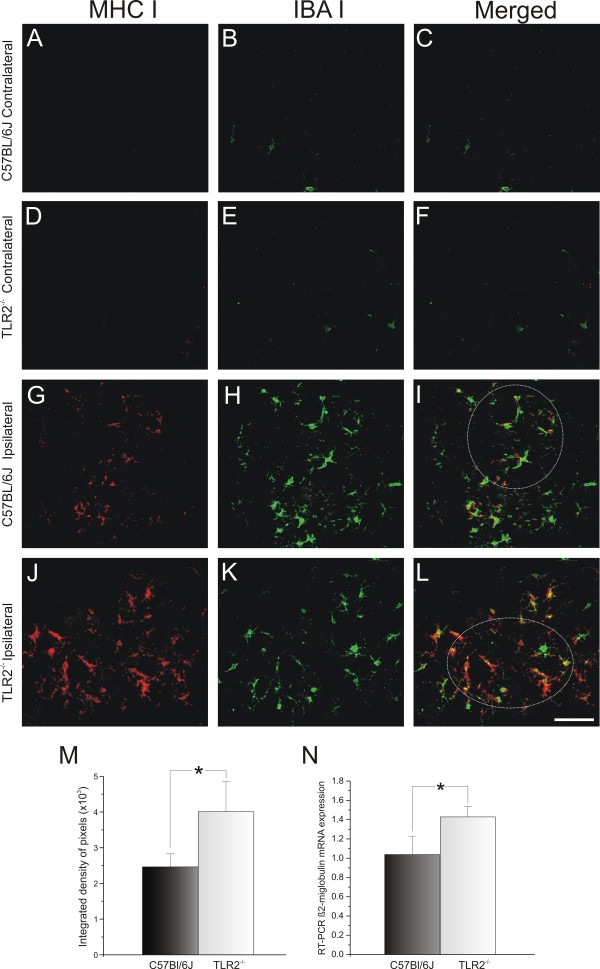
Major histocompatibility complex class I (MHC I) and Iba1 double staining in C57BL6/J wild-type (WT) and Toll-like receptor (TLR)2 knockout (KO) mice (TLR2−/−) mice 1 week after axotomy. (B,E) The contralateral side showed slight IbaI labeling and (A,D) no MHC I in both groups. There was greater upregulation of MHC I (J) in KO mice after lesion compared with (G) WT. (I,L) Colocalization of Iba1 and MHC I labeling, indicating that microglia express MHC I. (M) Graph representing the quantification of the integrated density of pixels for MHC I immunolabeling adjacent to motor neurons. (N) β2-Microglobulin mRNA level in the lumbar spinal cord determined by reverse transcriptase PCR; both graphs show greater MHC I upregulation in TLR2−/− mice after unilateral sciatic nerve axotomy. * P<0.05. Scale bar: 50 μm.